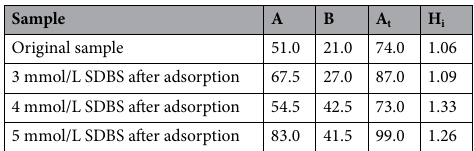
Table 4. The required parameters and calculation results of crystallinity